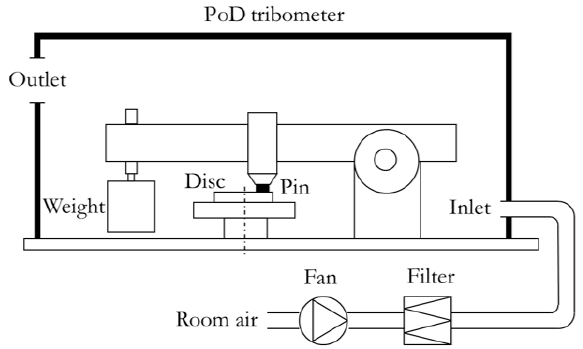
Figure 3. An overview of the pin-on-disc (PoD) setup with its important parts marked [15].